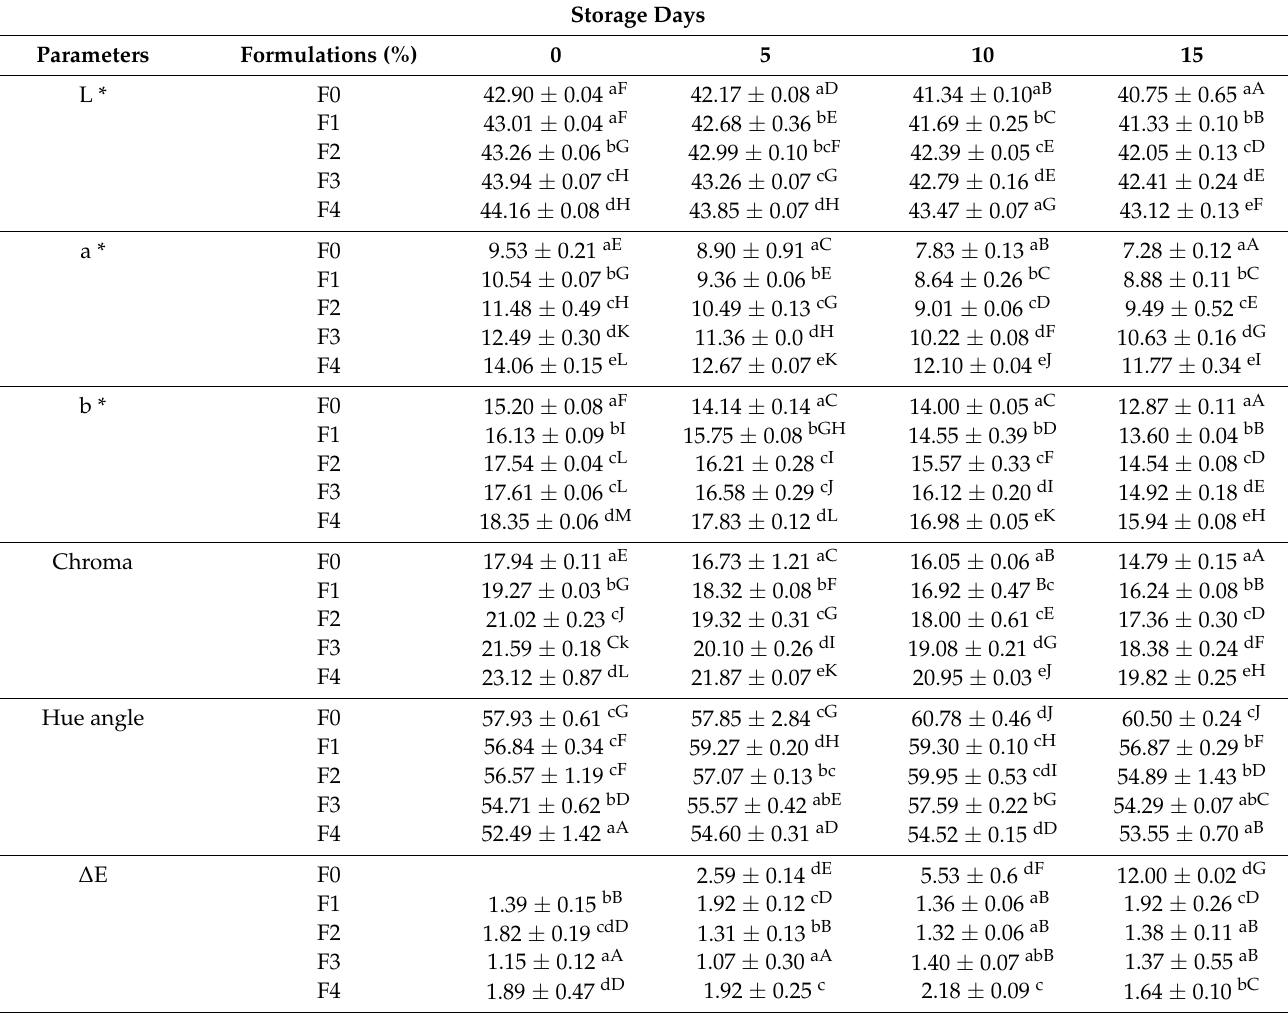
Table 4. Effects of MOLP on colour properties of ground beef stored at 4 ± 1 ◦ C for 15